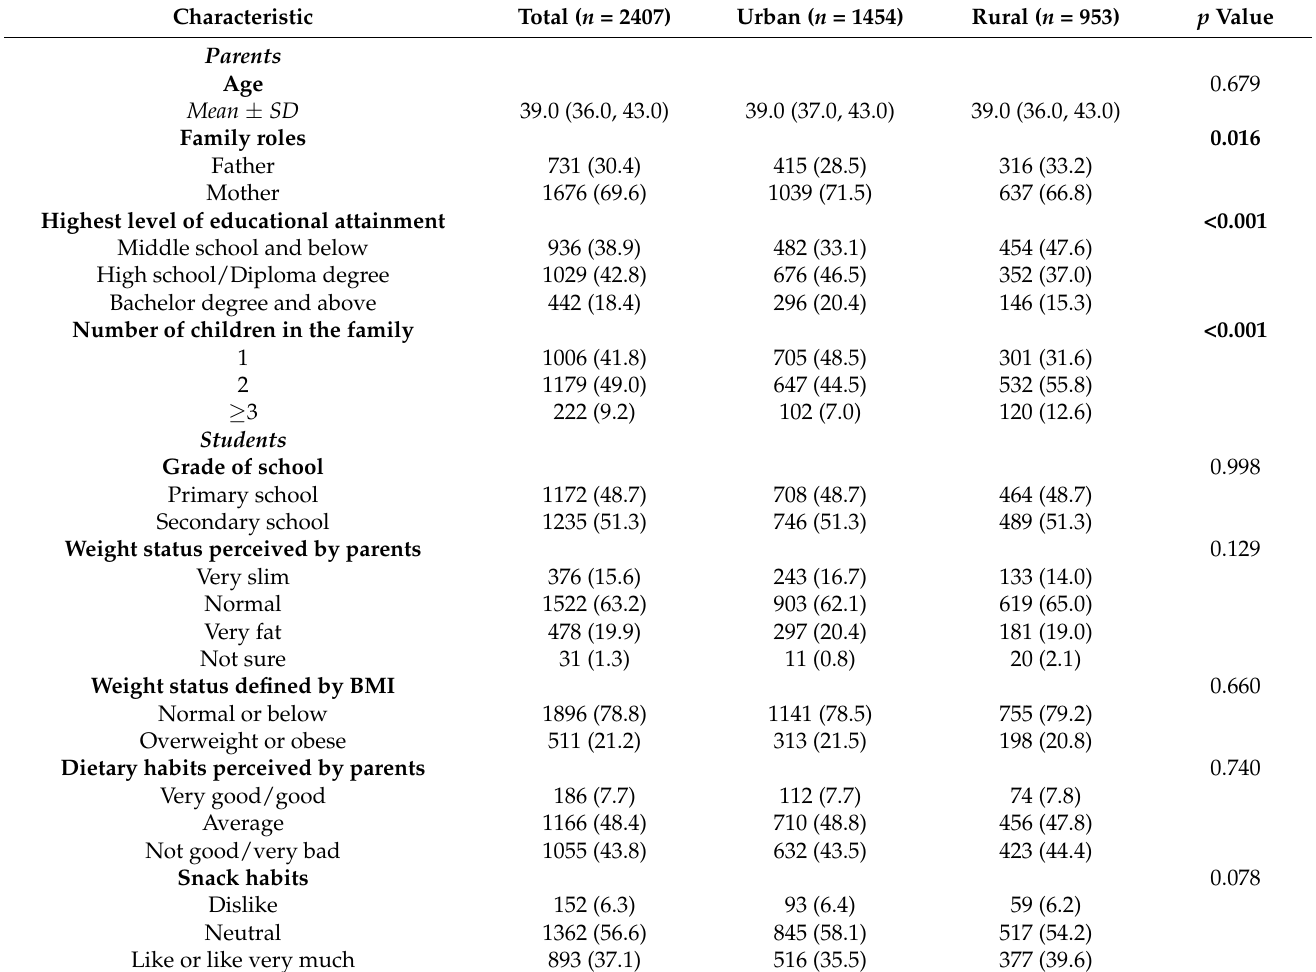
Table 1. Characteristics of Chinese parents participating in the study: n